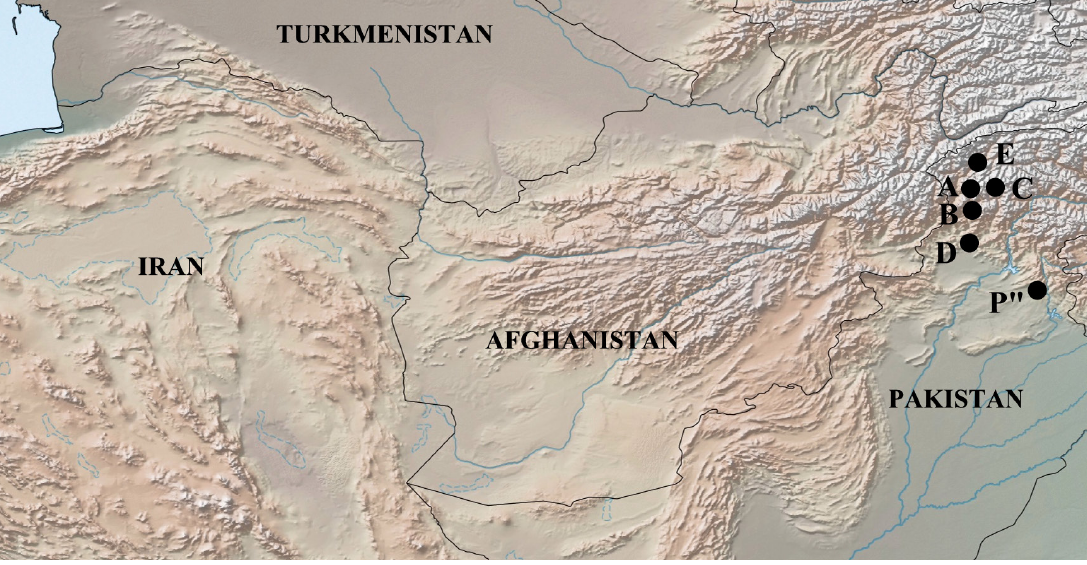
Fig. 5. Distribution of M. lutko Evans, 1932. For a description of the dots with letters see Fig.